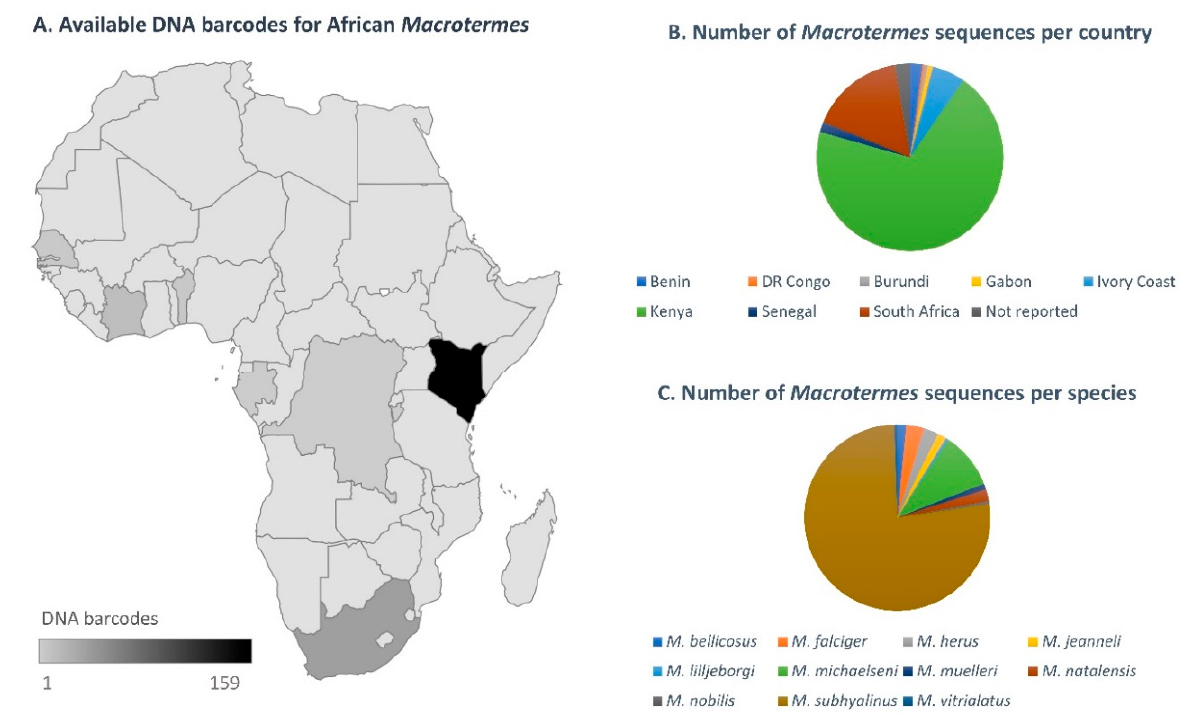
Figure 2. ( A ) Distribution of DNA barcodes for Macrotermes species in African countries, as determined using the complete dataset of sequences available on GenBank as of April 2021, and the new sequences generated in this study. ( B ) Number of DNA barcodes available per species, as of April 2021 (including the new sequences generated in this study). ( C ) Number of sequences available per species (not including new data generated in this study).